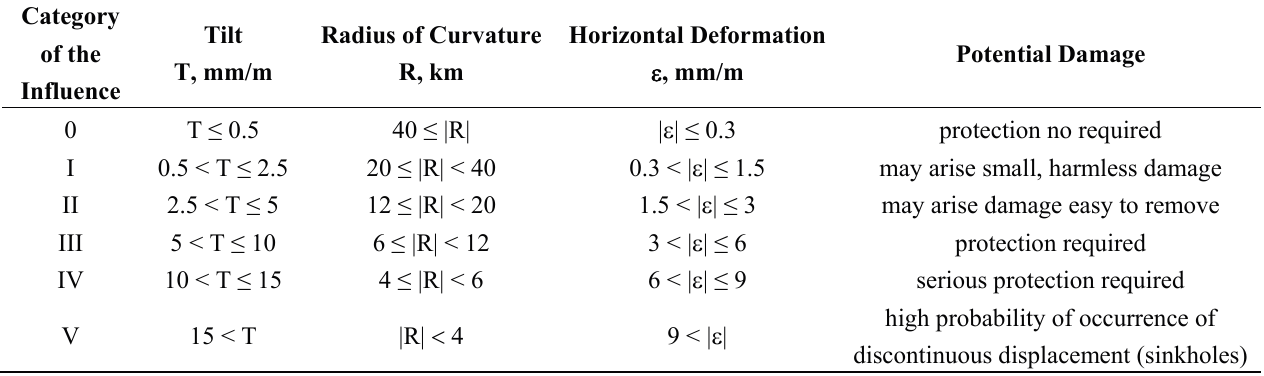
Table 1. Current existing categories of mining areas due to the continuous surface deformation [33].